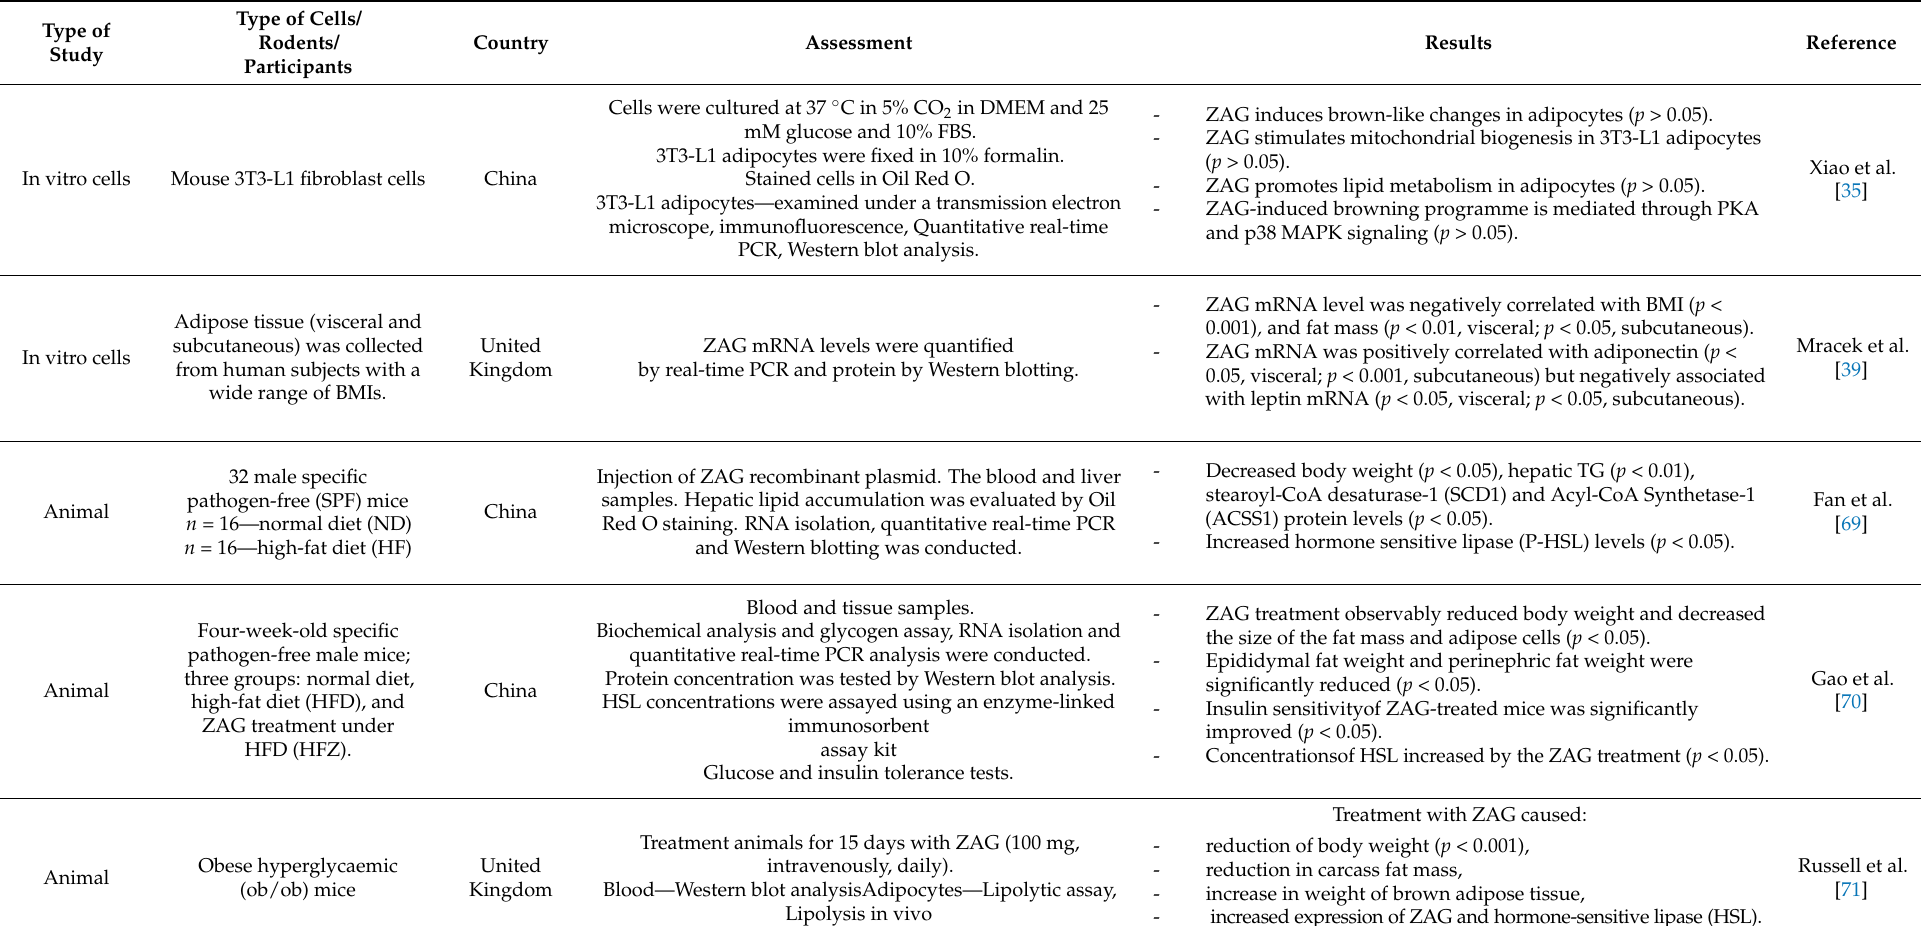
Table 3. Impact of ZAG on lipid